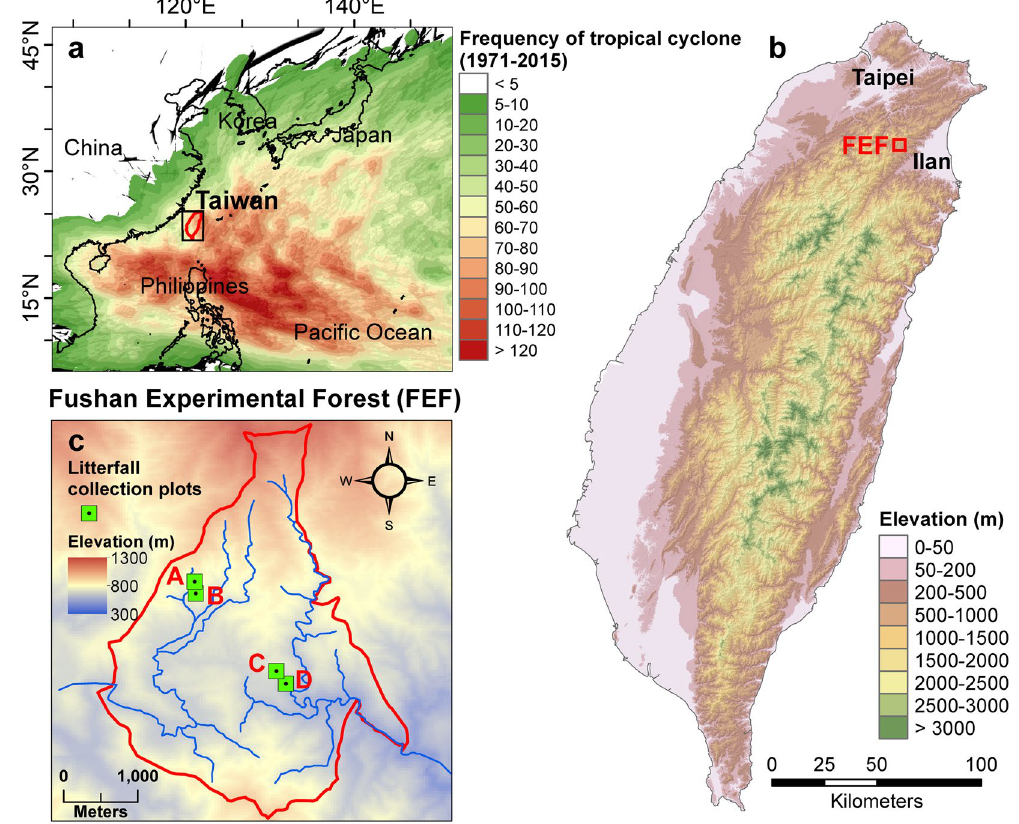
Figure 1. Location map of the Fushan Experimental Forest (FEF). The frequency of tropical cyclones in Northwest Pacific ( a ), location of FEF ( b ), and litterfall collection plots within FEF ( c ). The countries’ boundary map was generated from the map database in ArcGIS v. 10.3 53 . The frequency of tropical cyclone was presented in ArcGIS based on the grid map acquired from Joint Typhoon Warning Center (JTWC) 54 . The elevation maps of FEF and Taiwan (in background) were created based upon 20 m digital elevation model (DEM) obtained from Data.GOV.TW 55 . The litterfall collection plots were built and plotted using Tools in ArcGIS by their coordinates.